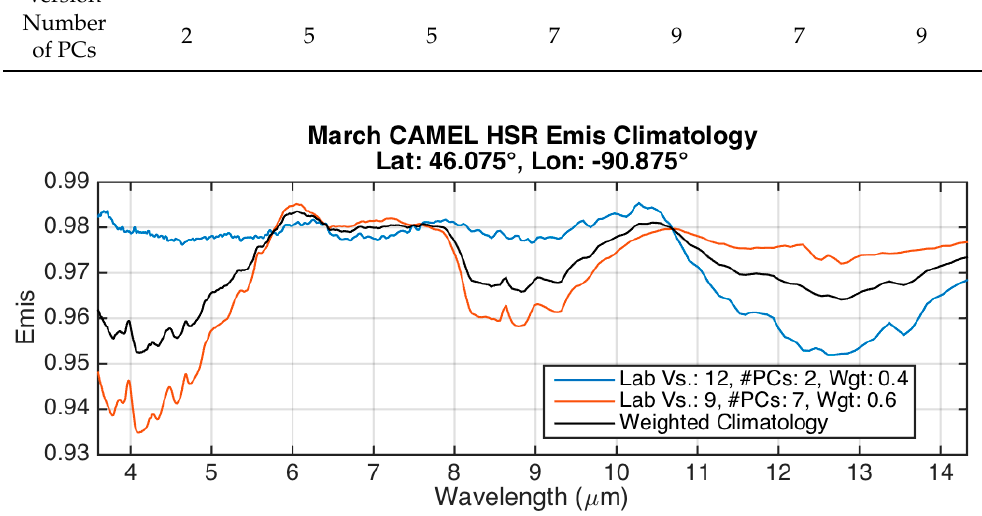
Figure 1. Illustration of the CAMEL HSR emissivity climatology computation for March over northern Wisconsin. Intermediate spectra are shown in color for the 2 lab versions and number of PCs sets used: lab version 12/2 PCs and lab version 9/7 PCs. The final HSR climatology is shown in black and is obtained via a weighted average of the two intermediate spectra.